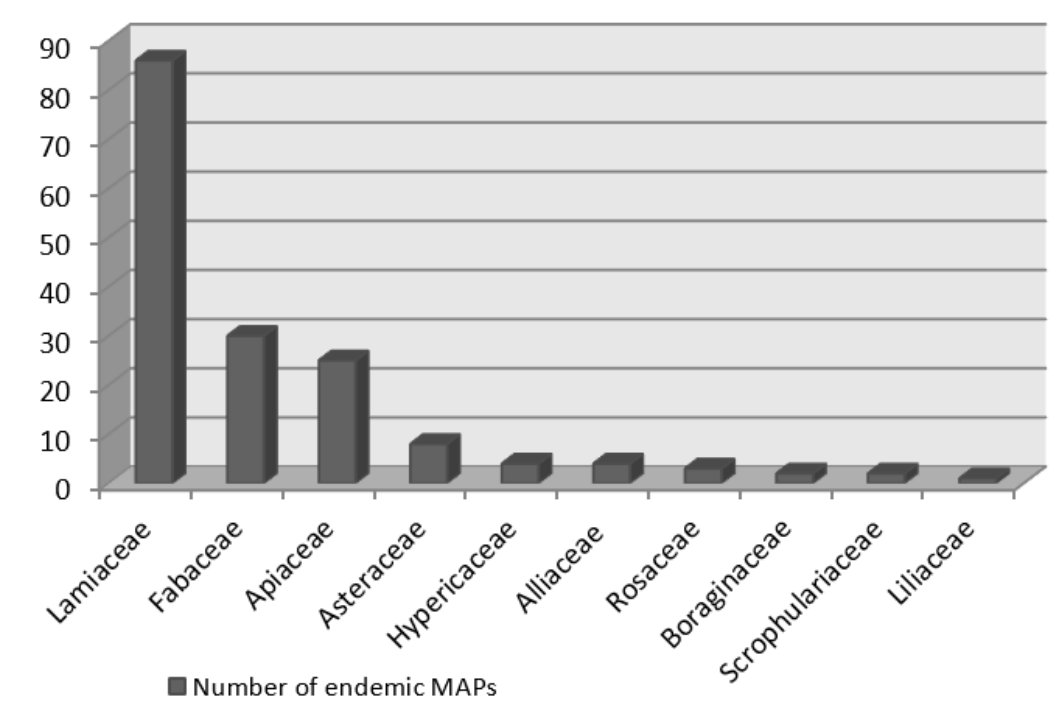
Figure 1. The species number of the ten most endemic-rich families of Iranian medicinal and aromatic plants.